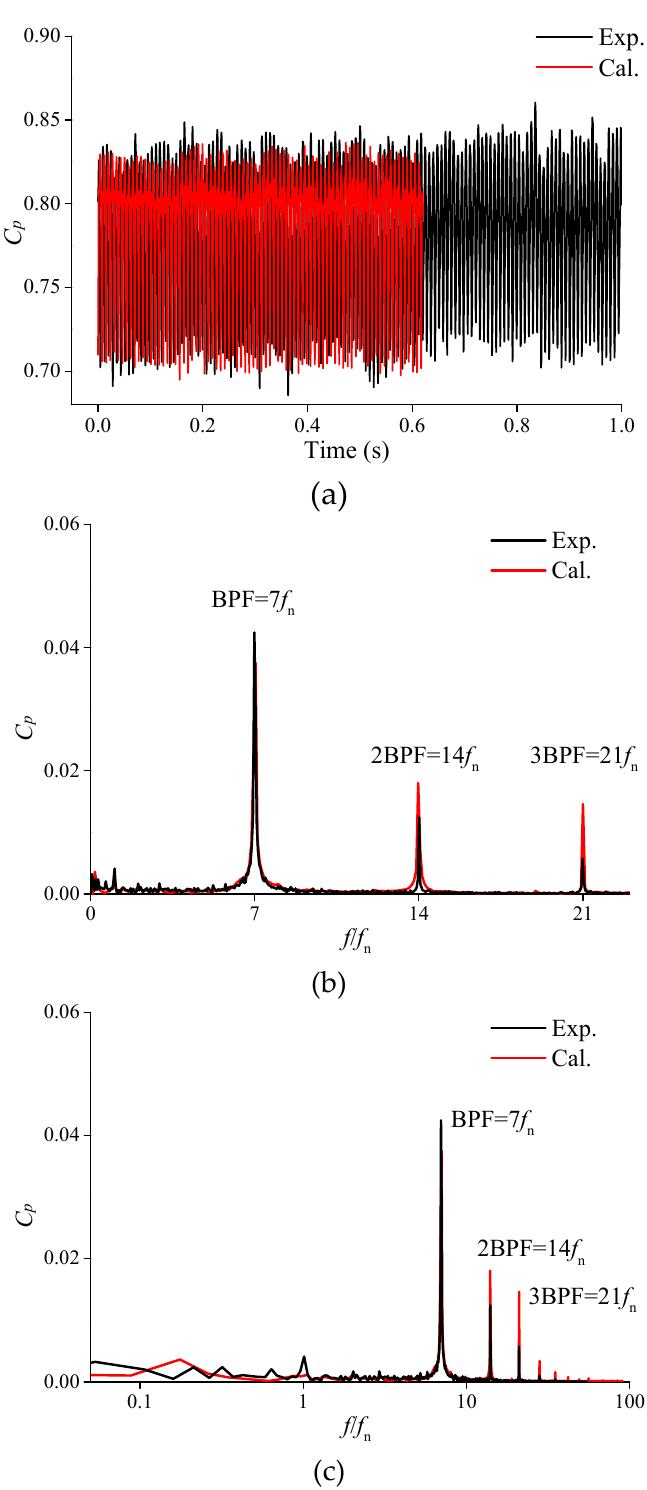
Figure 7. Pump performance curves at ( a ) α =45%, (b) α =75% and ( c ) α =145%.